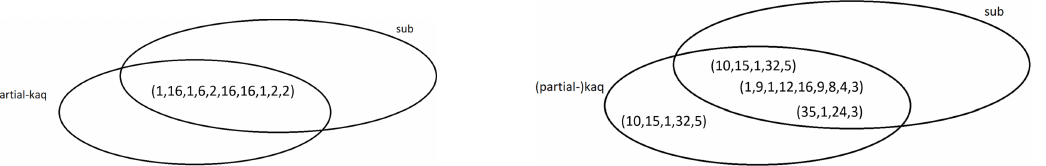
Figure 6 . su (8) : On the left ( L 24 ), we have one degeneracy pattern which is partial- kaq and all its instances are sub . On the right ( L ), the degeneracy pattern (10 , 15 , 1 , 32 , 5) for k = 500 has 11 26 kaq instances and 17 partial- kaq instances (which obviously includes the previous 11), all of which are non- sub . However the same pattern for k = 1000 , with only partial- kaq results, is sub (by the combination of 10 D + 15 D eigenspaces), along with all the other partial- kaq solutions for k = 1000